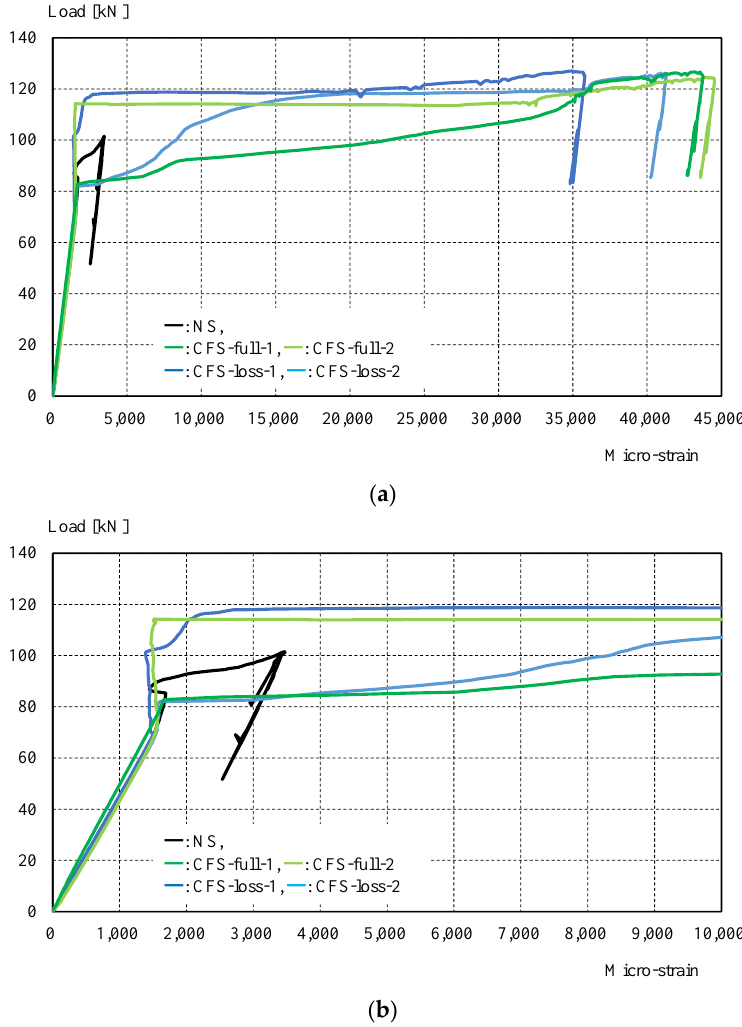
Figure 14. Load–strain (average of g2 and g3) relations: ( a ) a range of 0–4.5% strain; ( b ) a range of 0–1%